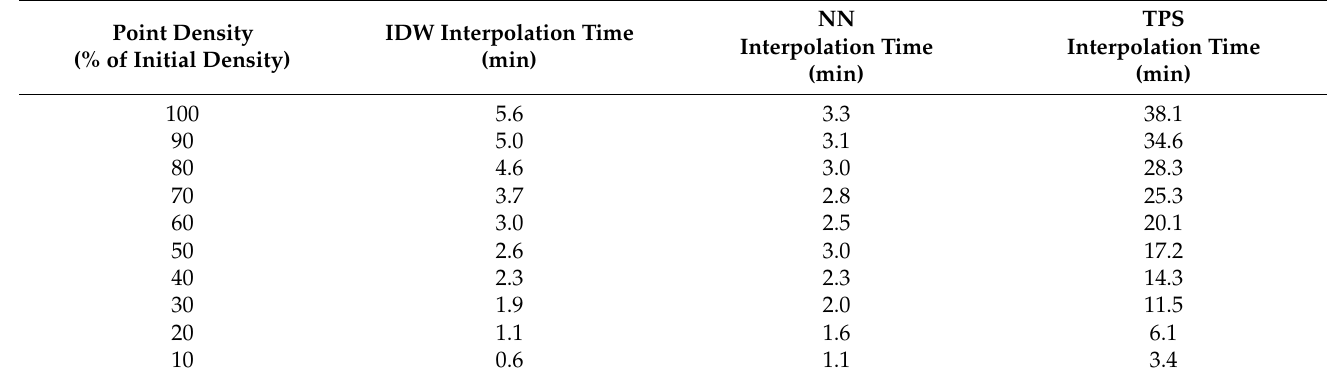
Table 3. Processing time for DTM